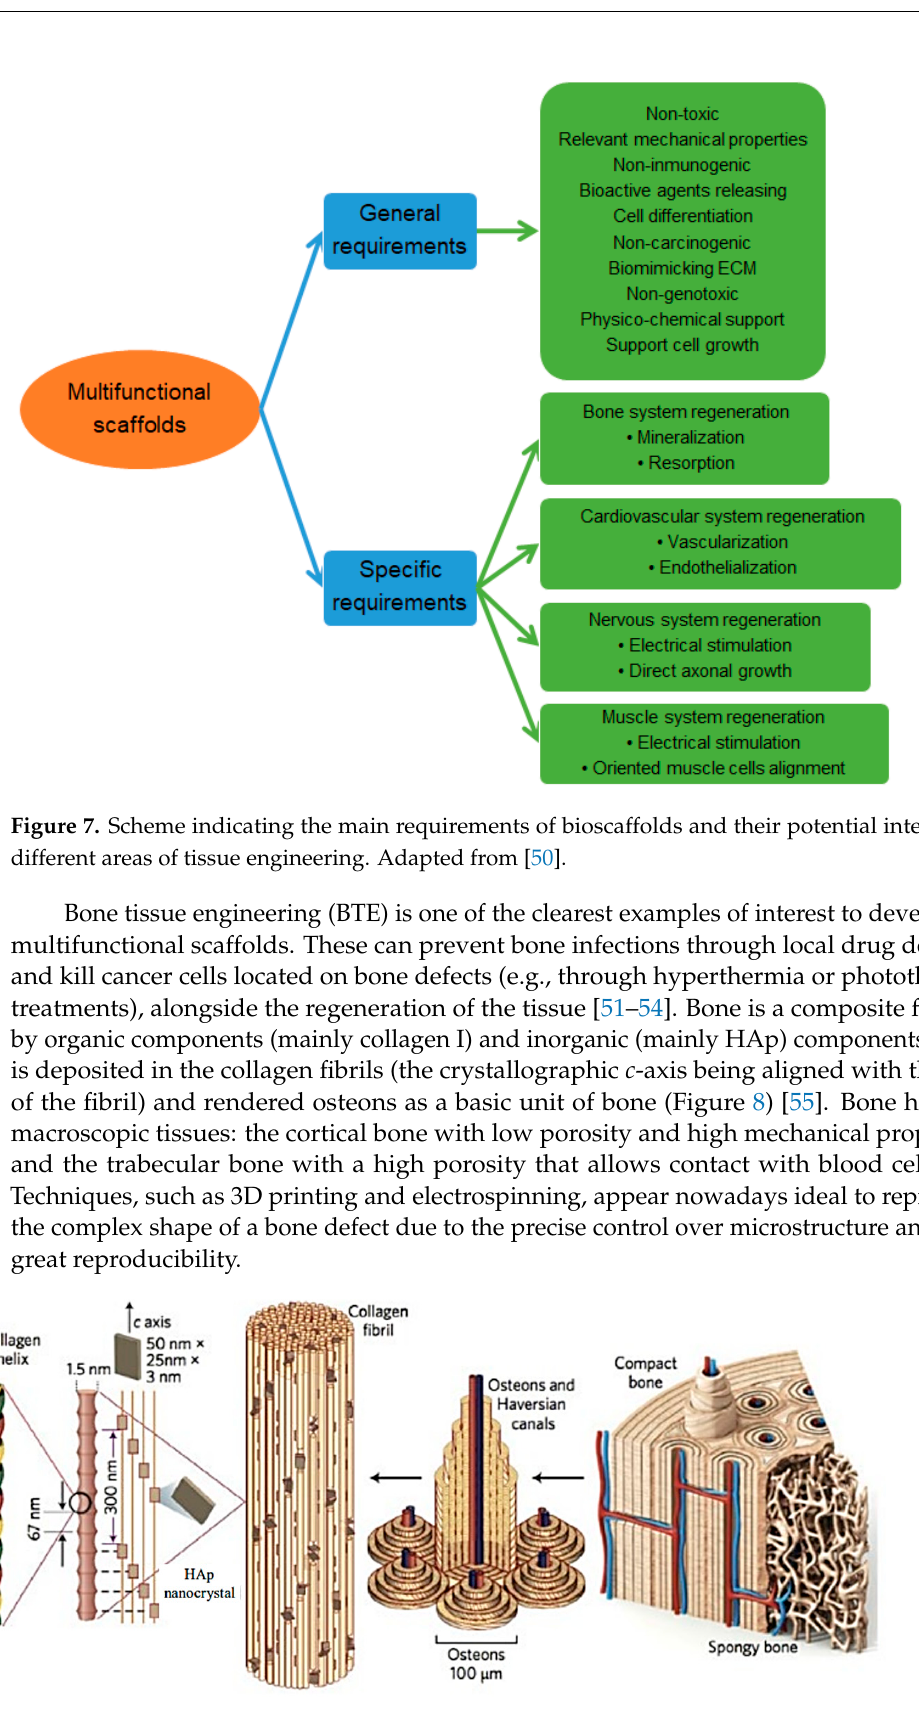
3. Multifunctional Scaffolds